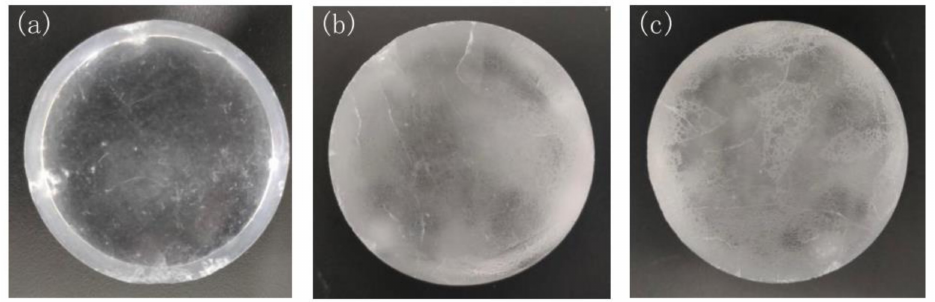
Figure 3. CsI(Na) crystal (size: Φ 50 mm × 29 mm) ( a – c ) exposed to 85% relative humidity air for 0, 8, and 10 h